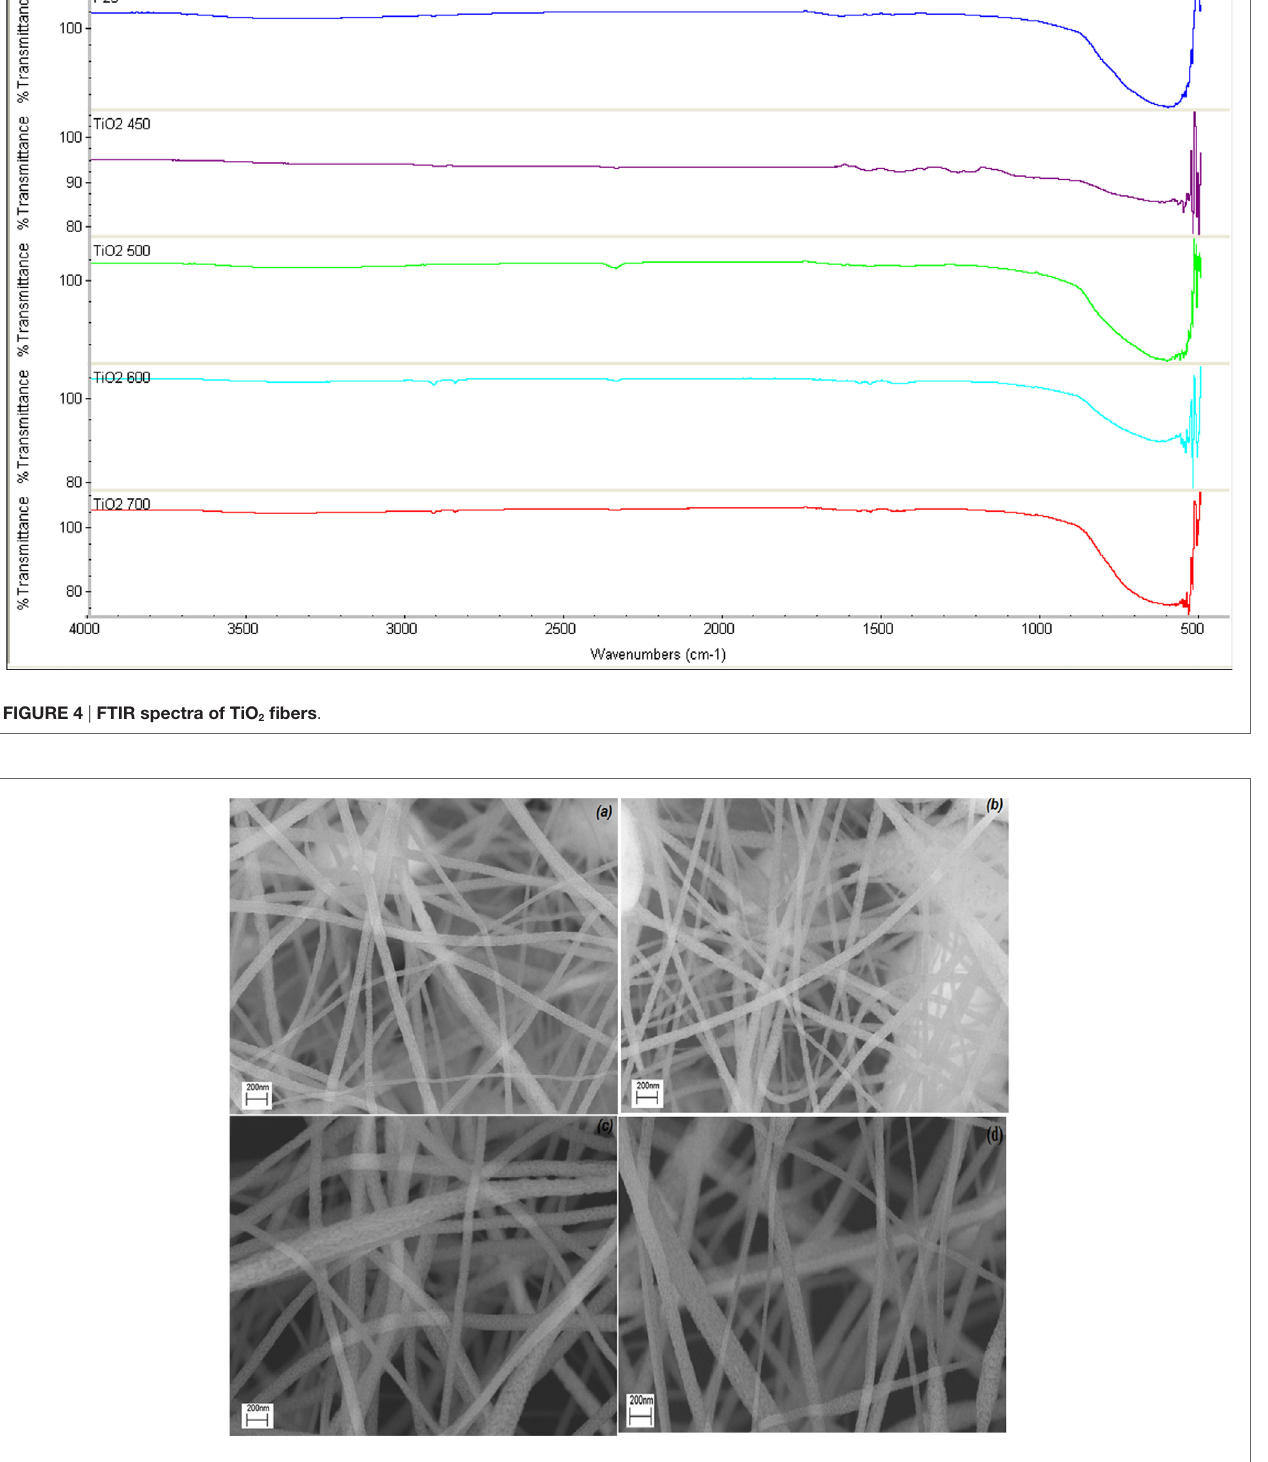
FigUre 5 | seM images of pure TiO 2 nanofibers annealed at (a) 450°c, (B) 500°c, (c) 600°c, and (D) 700°c .